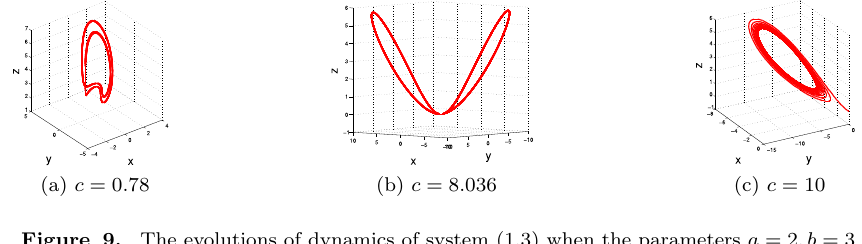
Figure 9. The evolutions of dynamics of system (1.3) when the parameters a = 2 ,b = 3 and c varies and the initial value ( x 0 ,y 0 ,z 0 ) = ( − 3 . 82 × 1 e − 5 , − 6 . 18 × 1 e − 5 , 0): (a) period-doubling bifurcations, (b) a limit cycle encircling E ± , (c) a limit cycle encircling E + or E −